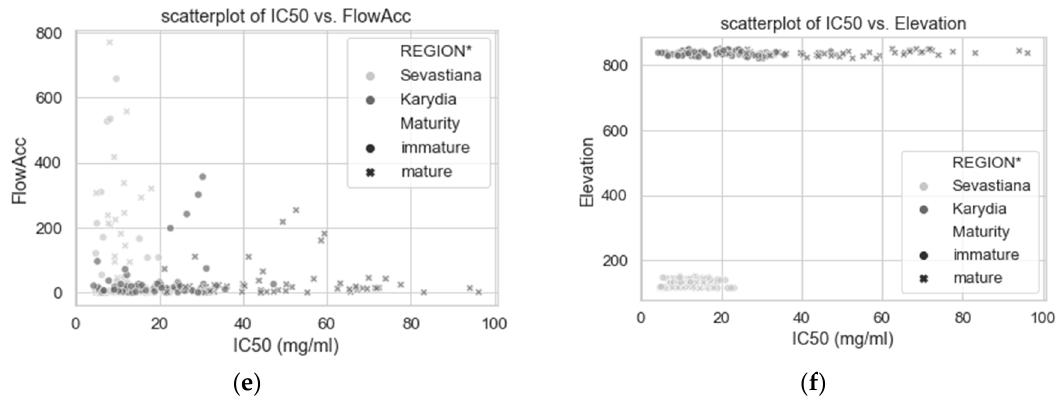
Figure 10. Scatter plots spotting data from Sevastiana area having low IC 50 values in the DPPH assay at ( a ) specific levels of boron (B), ( b ) magnesium (Mg), ( c ) organic matter content (OM), ( d ) soil acidity (pH), ( e ) flow accumulation (FlowAcc) and ( f ) elevation.